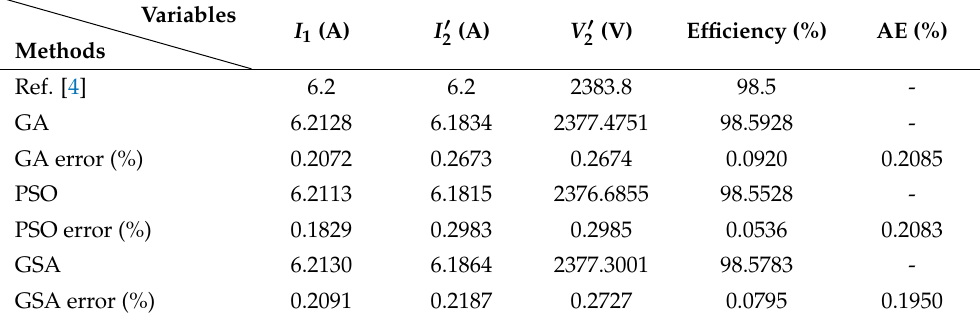
Table 6. Electrical variables at full load of a single-phase transformer 15 kVA, 2400–240 V, at 50 Hz.